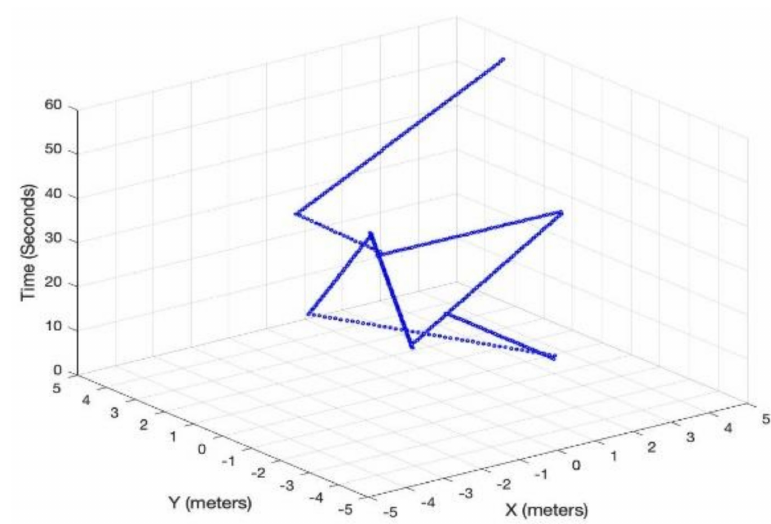
Figure 3. User mobility.